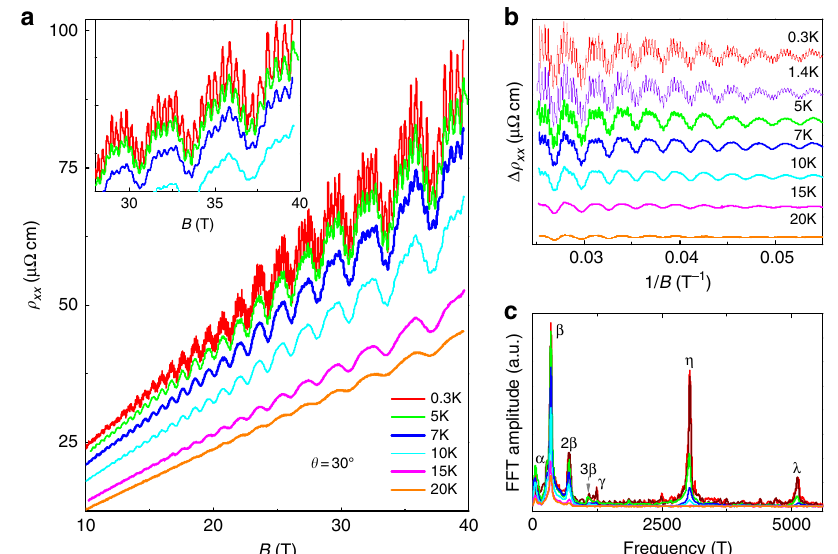
Fig. 3 SdH oscillations in magnetic fi elds up to 40 T. a Magnetic fi eld dependence of resistivity at different temperatures when the fi eld is applied along θ = 30°. b SdH oscillatory components as a function of 1/ B after subtracting a smooth background. c Corresponding FFT spectra of